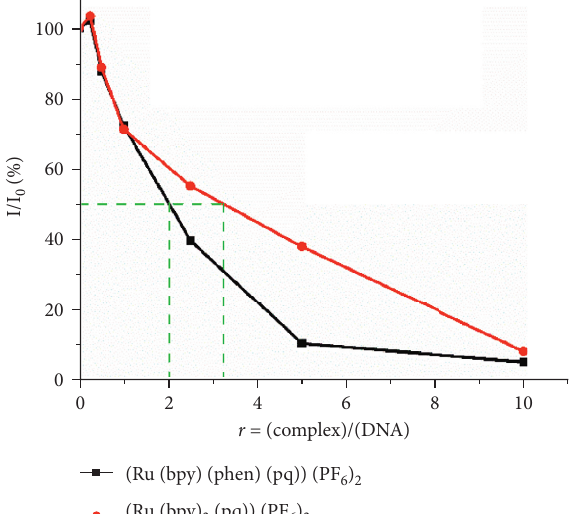
Figure 8: The % relative intensity of fluorescence emission of EB at λ in tris-HCL buffer (150mM NaCl, pH �